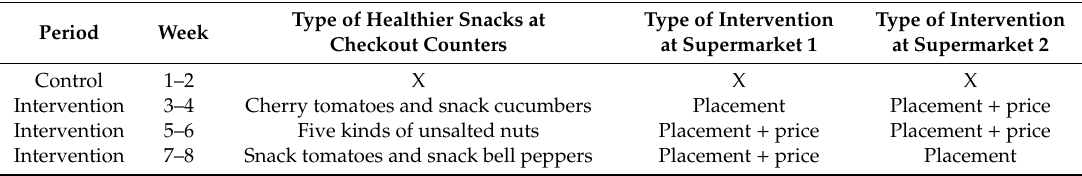
Table 1. Healthy Checkout Counter (HCC) intervention (period, type of healthier snacks and type of intervention (placement vs. placement + price) for each supermarket